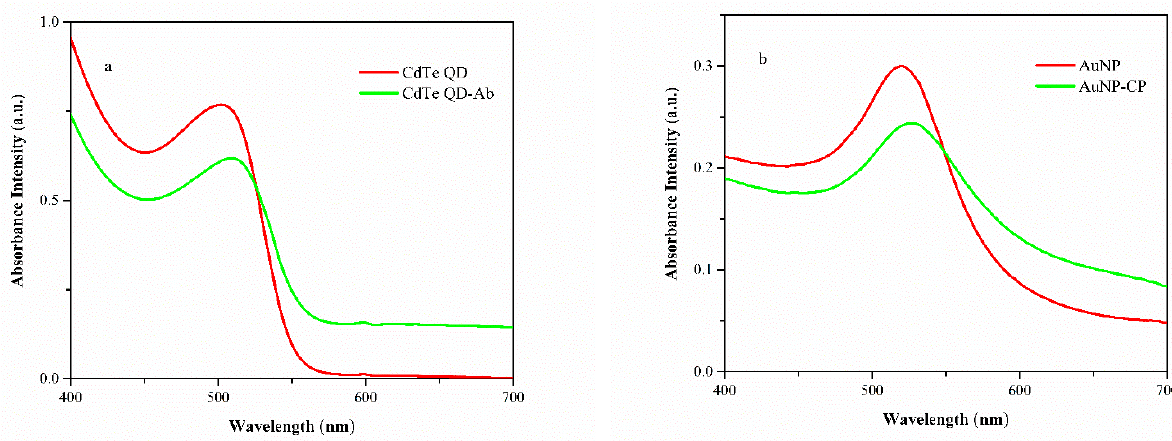
Figure 4. UV–vis absorption spectra of CdTe QD ( a ) and AuNP ( b ) before and after conjugated with corresponding proteins.